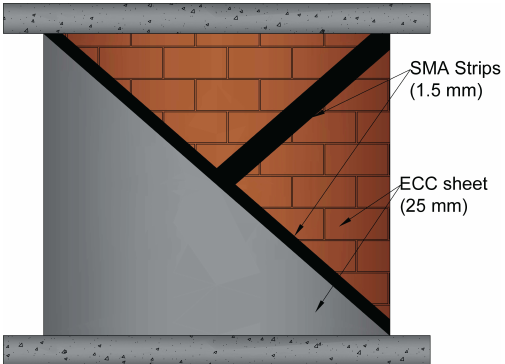
Figure 4. The numerically studied hybrid URM strengthening method using Ni–Ti strips and ECC